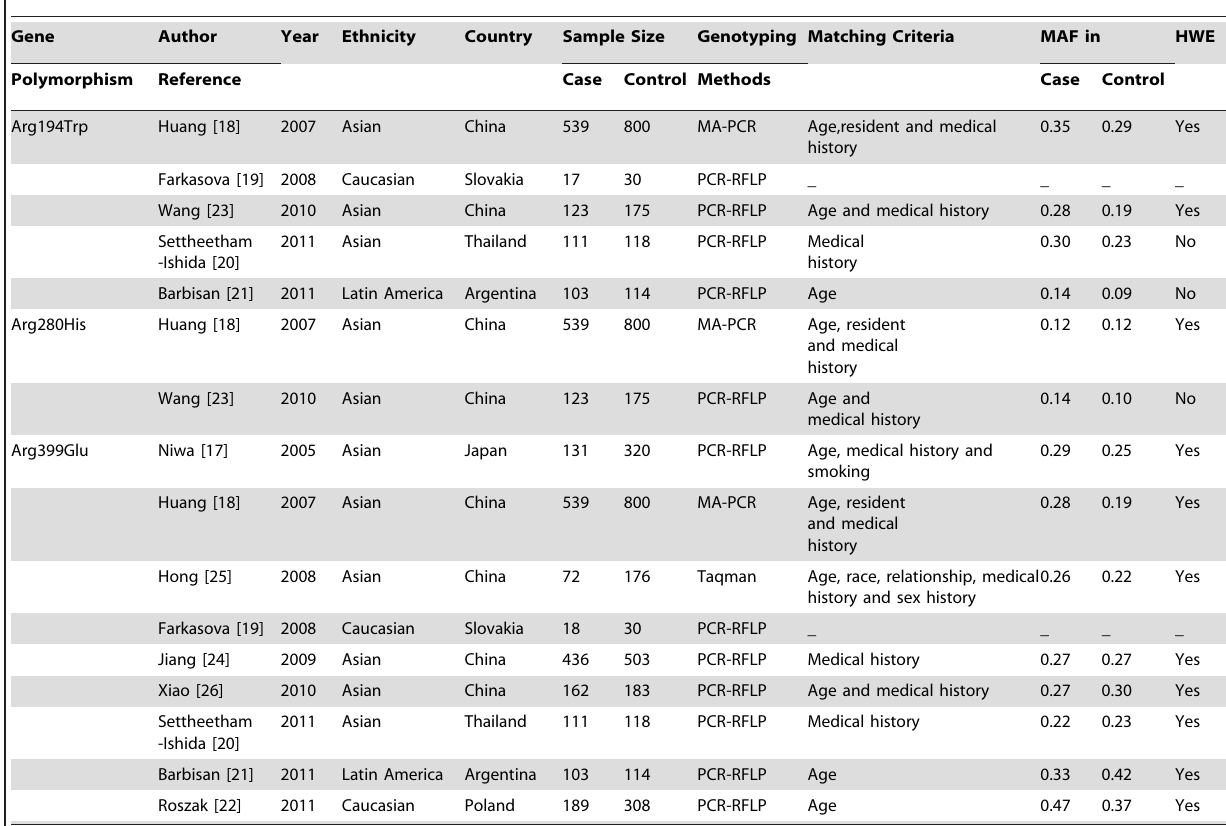
Table 1. Characteristics of studies included in this meta-analysis.